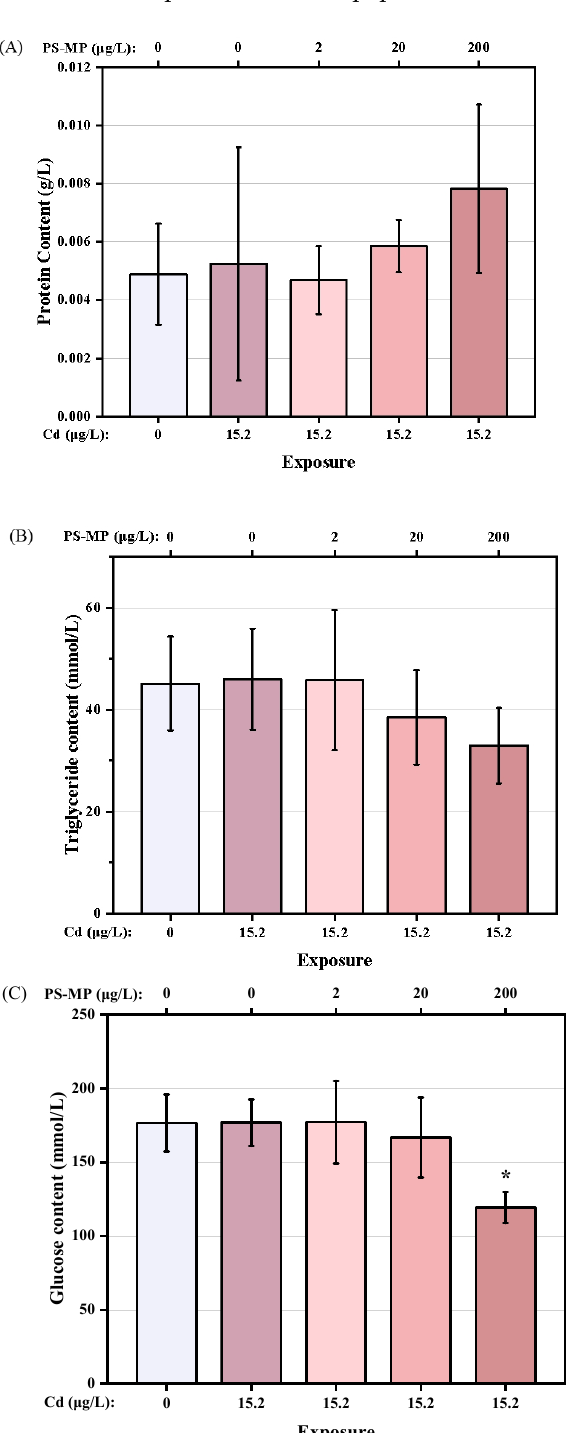
Figure 6. Nutritional components of T. japonicas exposure to Cd and microplastic. ( A ) Protein content, ( B ) Triglyceride content, and ( C ) Glucose content. Significant differences between the exposure and controlled groups are marked with * ( p < 0.05).